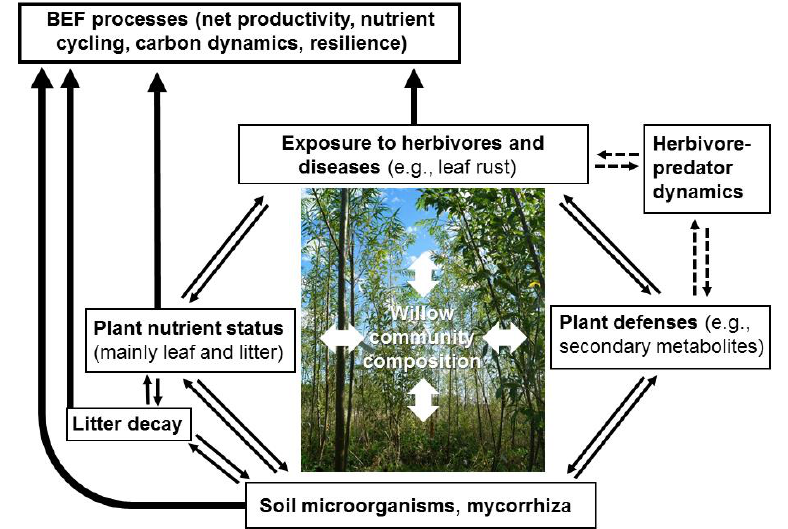
Overview of the links between ecosystem characteristics and processes currently researched in willow SRC systems (thin arrows), separated into bottom-up (solid lines) and top-down (dashed lines) interactions; and their connections to the overall ecosystem processes important for biodiversity–ecosystem function (BEF) (thick arrows). Bottom-up processes are those in which plant growth is a ff ected by the utilization of limited resources (e.g., nutrient elements), while top-down processes are those in which plant growth is a ff ected by the action of predators feeding on herbivores. Photo: Mixed willow SRC plantation near Uppsala, Sweden; the willow shoots are three years old (courtesy S. Hoeber, SLU).